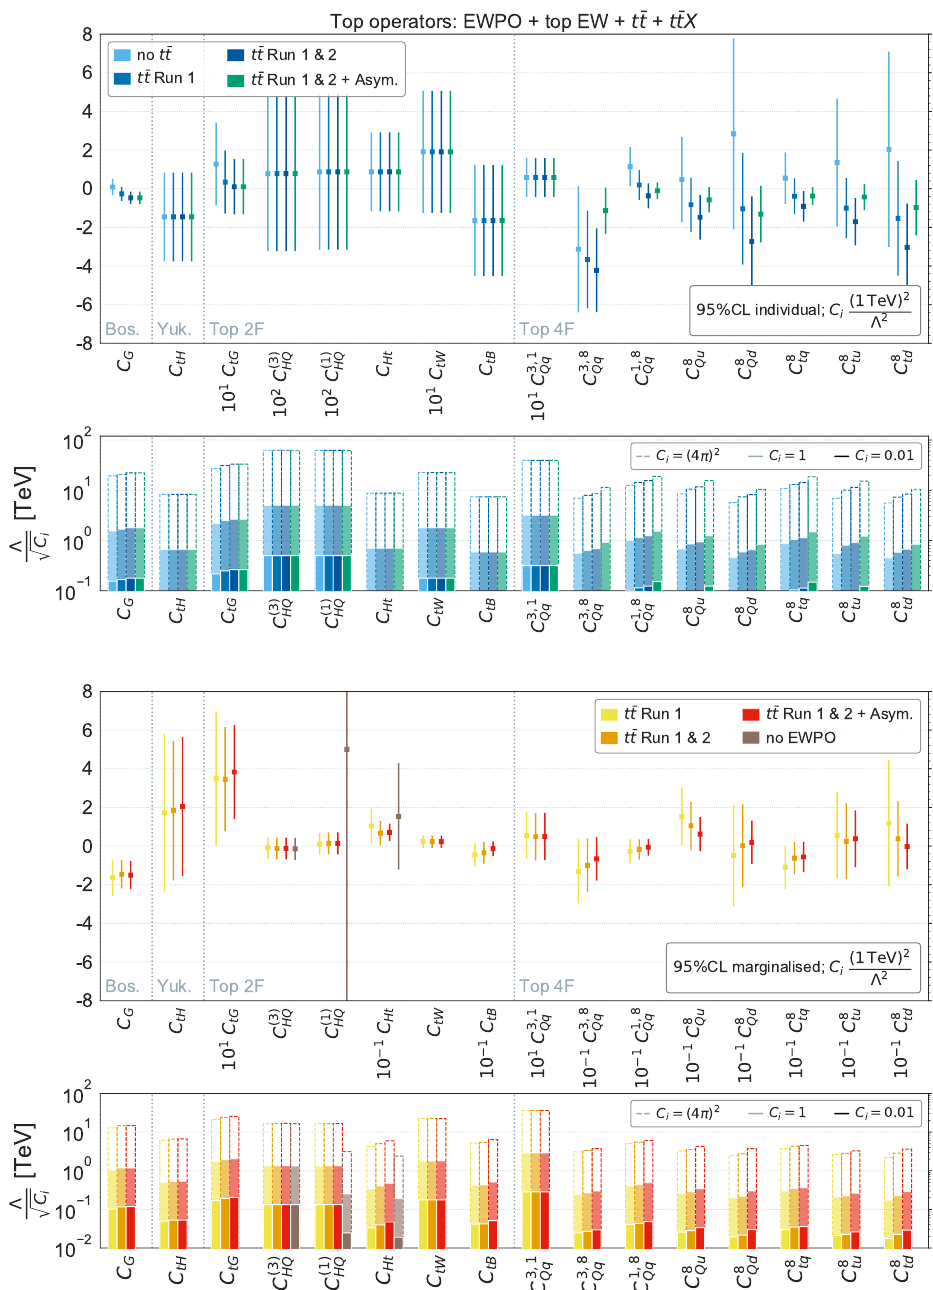
Figure 5 . Constraints on the indicated individual and marginalised operator coefficients at the 95% confidence level (upper and lower figures, respectively), from a combined linear fit to the top data and electroweak precision observables. The impact of t ¯ t data is highlighted by the evolution of the constraints starting from no t ¯ t data (light blue/yellow) adding Run 1 t ¯ t total and differential cross-section data (blue/pink), the corresponding Run 2 t ¯ t data (purple/orange), and finally t ¯ t asymmetry measurements A from the Tevatron and A from the LHC FB C